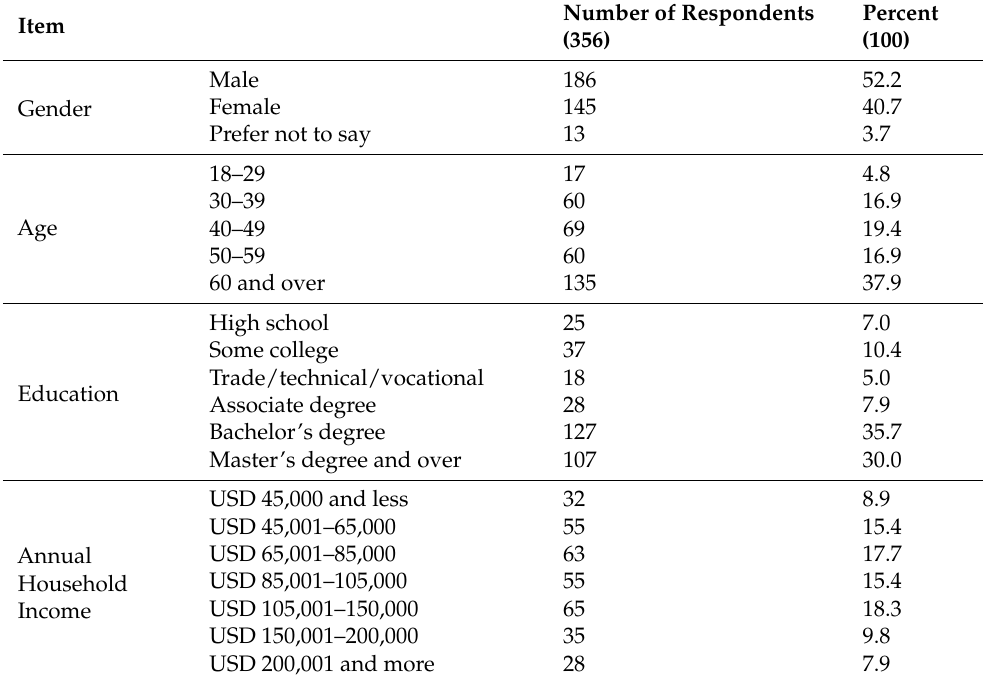
Table 3. Distribution of Respondents by Sociodemographic Variables.